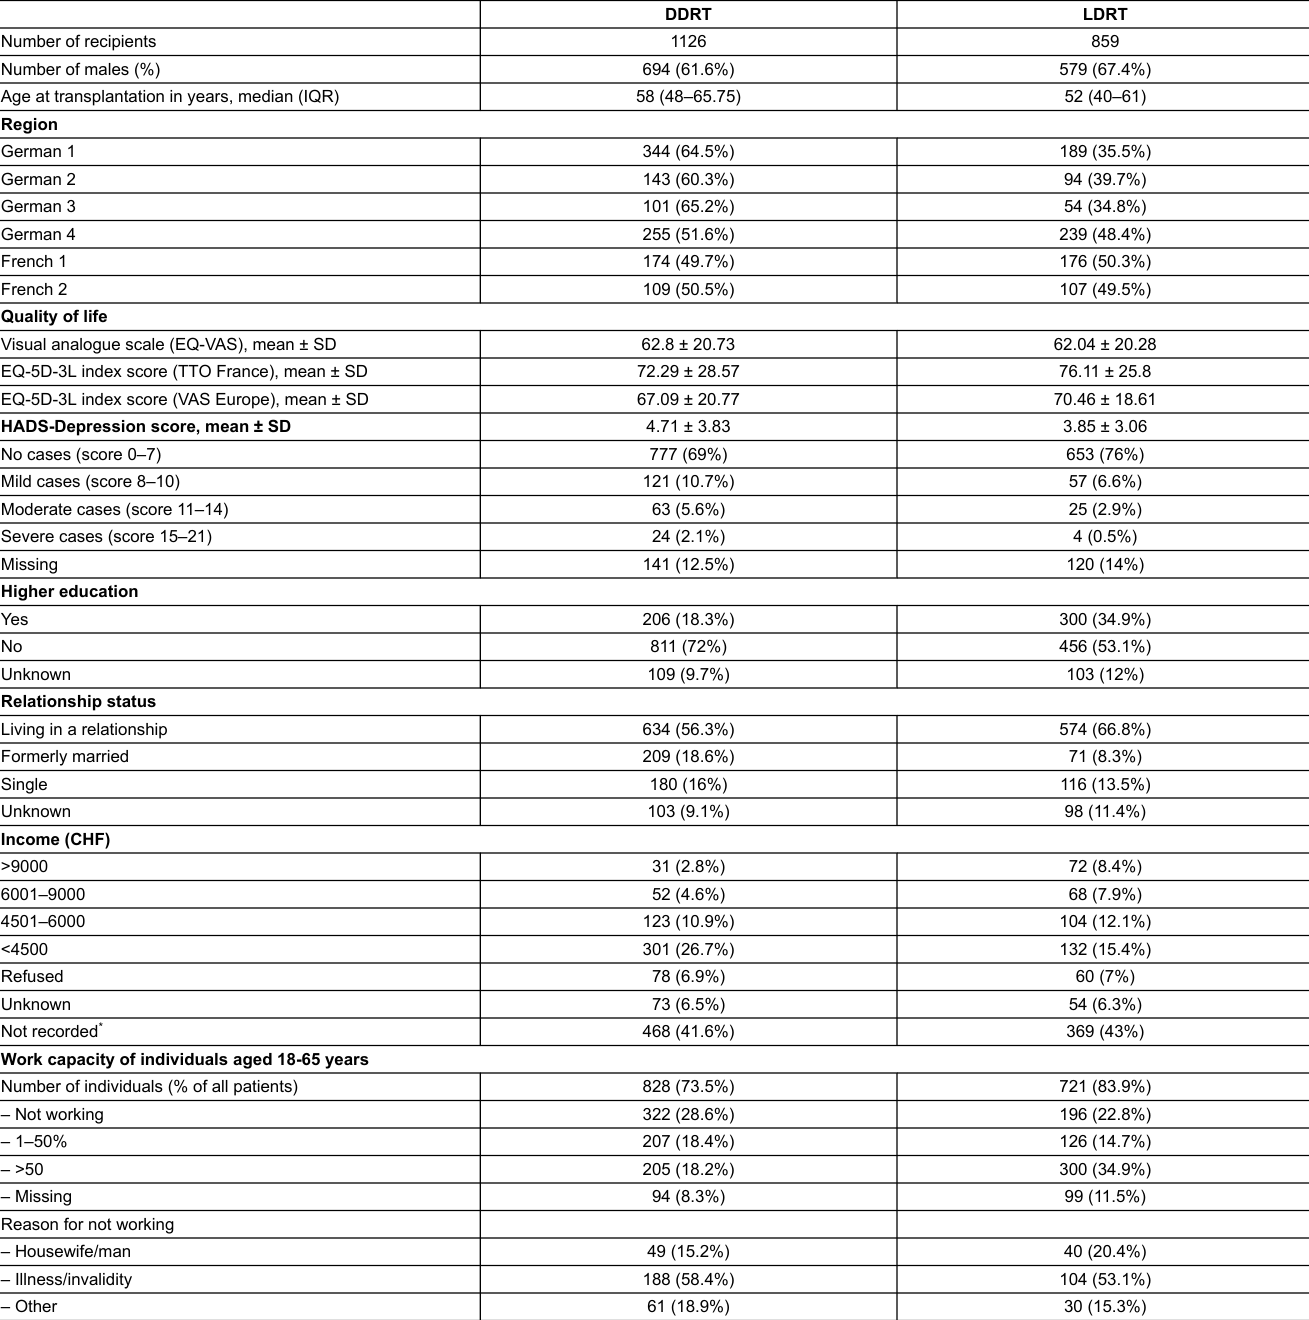
Table 1: Socioeconomic, demographic and health characteristics of renal transplant candidates by deceased (DDRT) and living (LDRT) donation. Number of